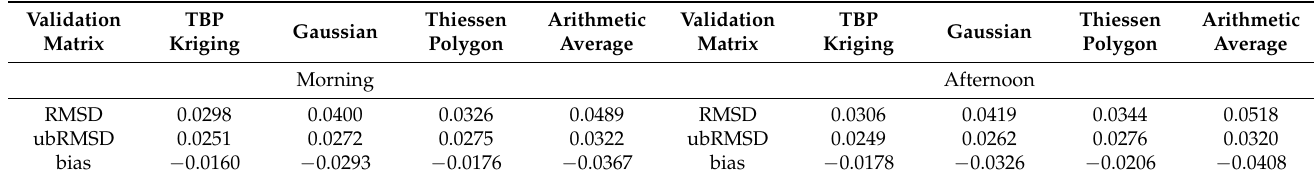
Table 3. Model Performance Comparison for the AM/PM Data for Grid 2.